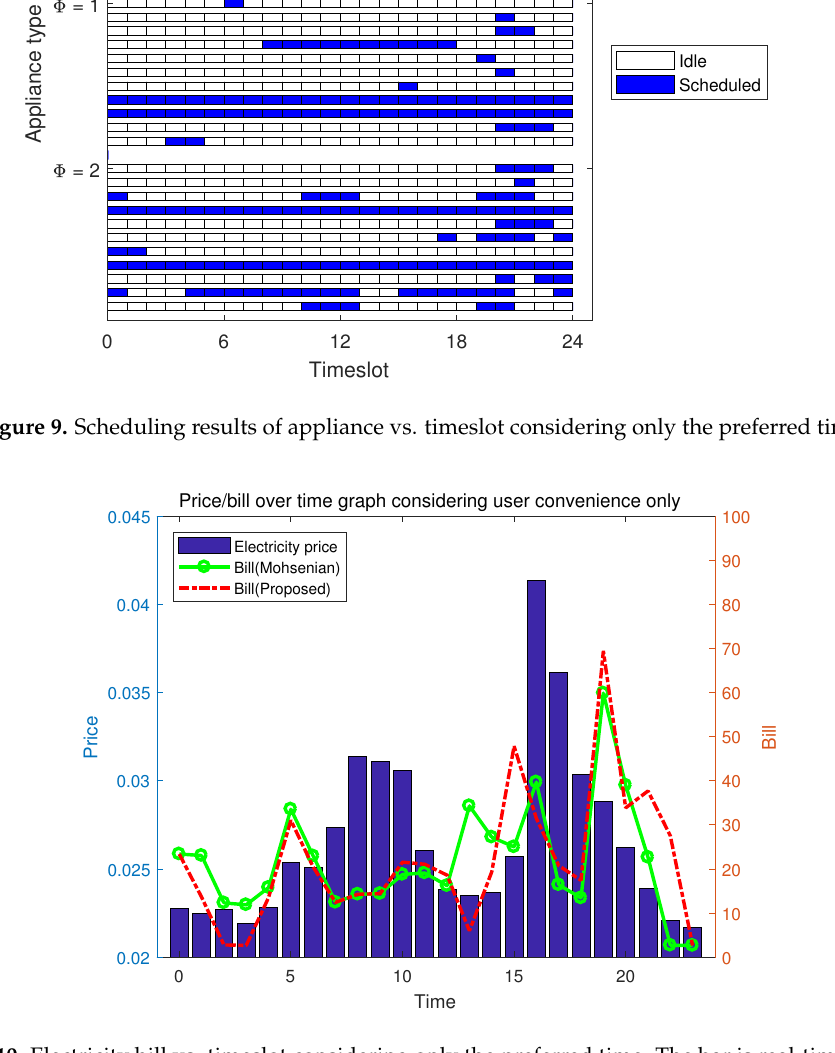
Figure 10. Electricity bill vs. timeslot considering only the preferred time. The bar is real-time pricing and the plot is the electricity